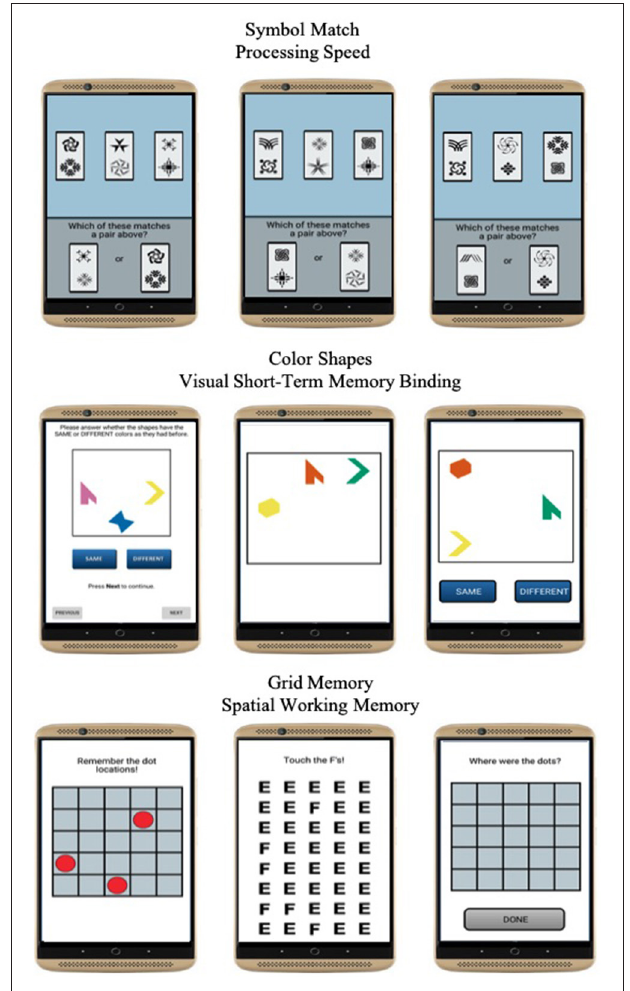
FIGURE 2 | Screenshots of mobile cognitive